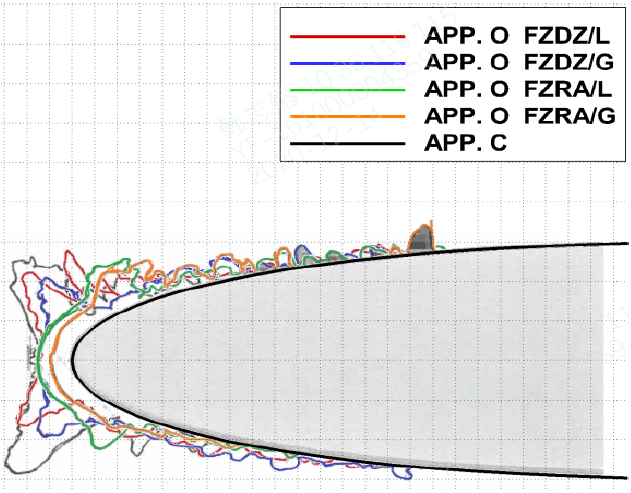
Figure 12. Ice shapes with single horn at AOA = 4.9°.